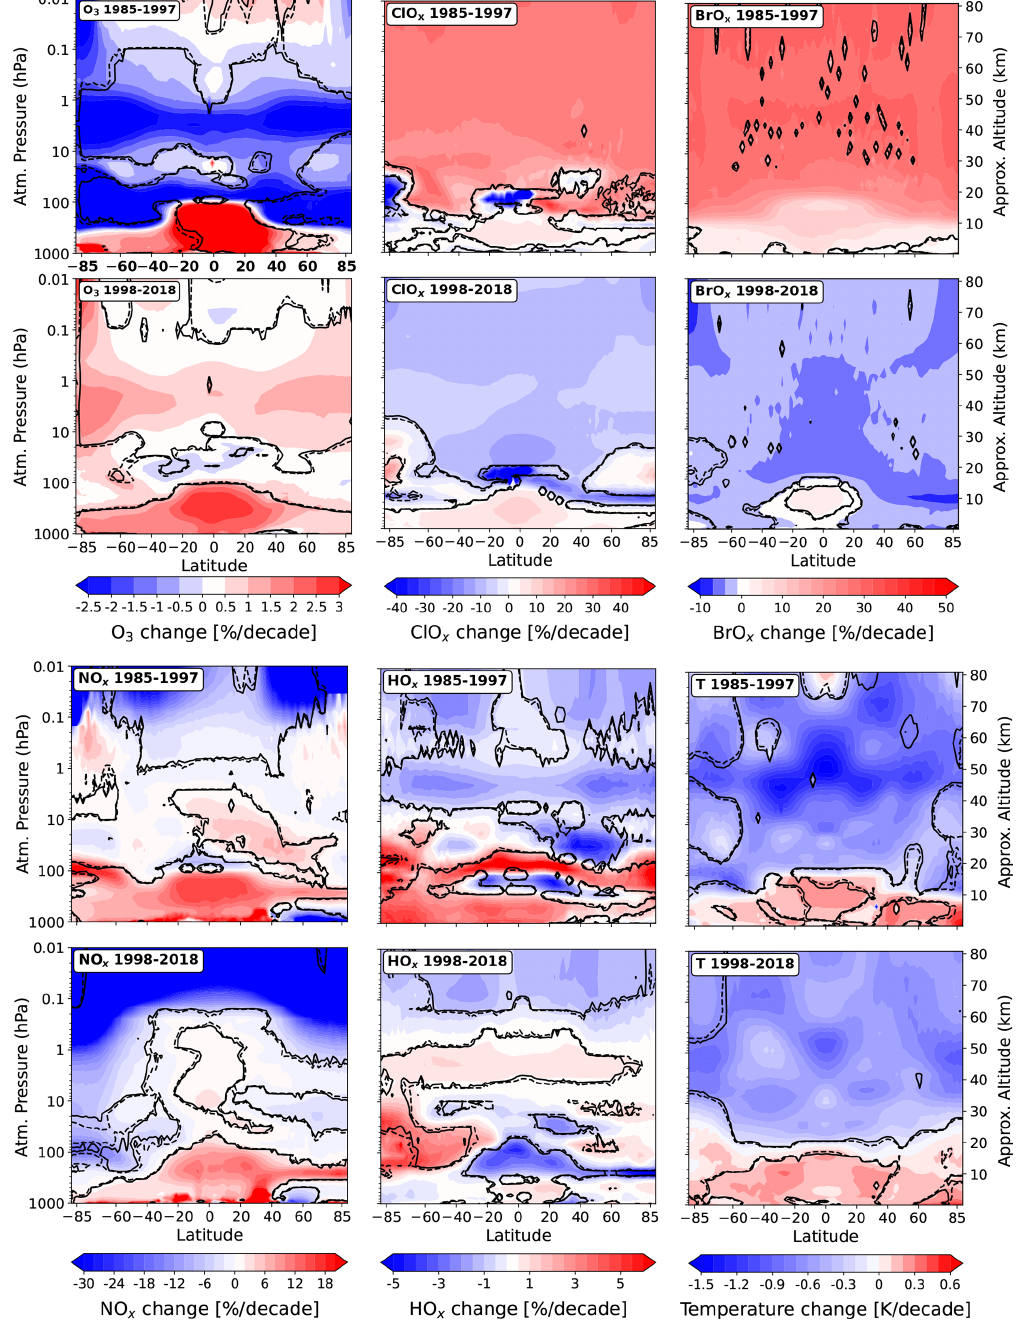
Figure 2. Ensemble mean trends of O 3 , ClO x , BrO x , NO x , HO x (% per decade), and temperature (K per decade) from the SOCOLv4 results. The dashed line is the delimiter of the region with significance at the 90% level for positive or negative changes; the solid line is the same at the 95%